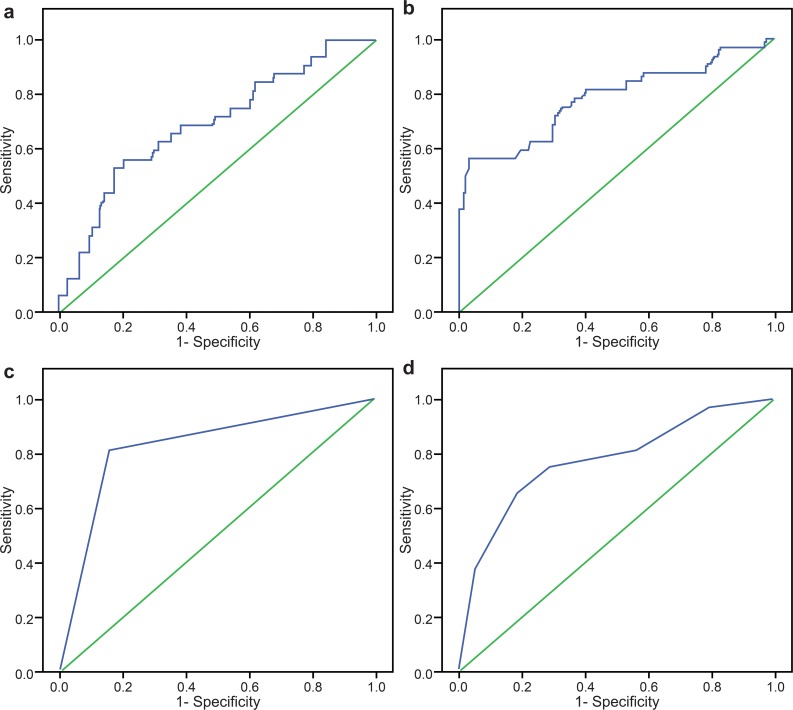
Receiver operating characteristic curves for serum procalcitonin and peripheral venous lactate in the prediction of dengue shock and/or organ failure at admission.(A) The area under the receiver operating characteristic curve (AUROC) for serum procalcitonin at admission was 0.69 (95% confidence interval [95% CI]: 0.59–0.80). (B) The AUROC for peripheral venous lactate at admission was 0.78 (95% CI: 0.68–0.88). (C) The AUROC for a combined bioscore at admission was 0.83 (95% CI: 0.74–0.92). (D) The AUROC for the number of warning signs at admission was 0.77 (95% CI: 0.68–0.87).